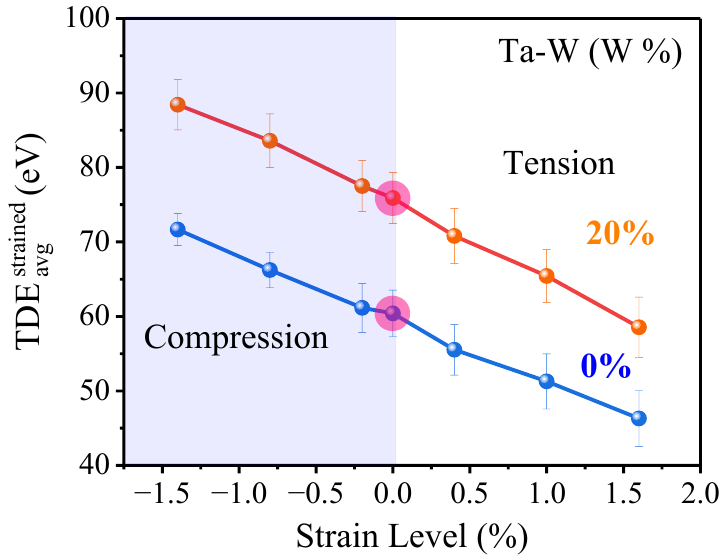
Figure 5. TDE istrained , as functions of the strain from compression to tension for pure Ta and Ta – i W.